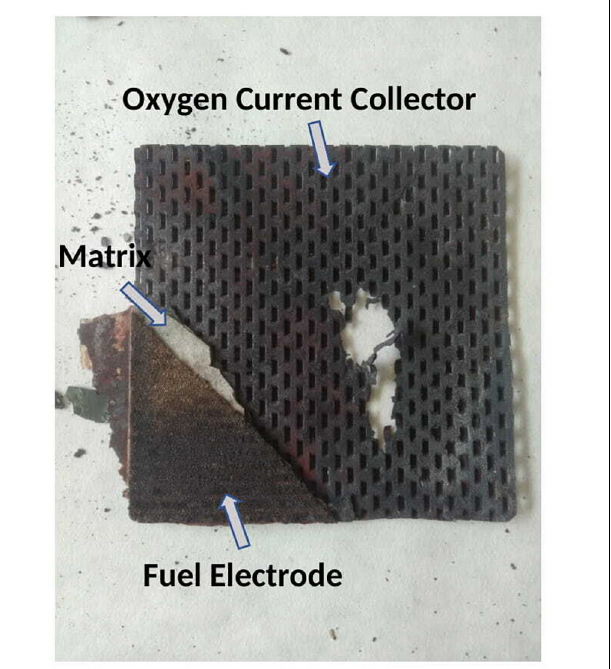
FIGURE 9 | Photograph showing the corrosion of the 316L steel oxygen current collector after the reverse MCFC cell